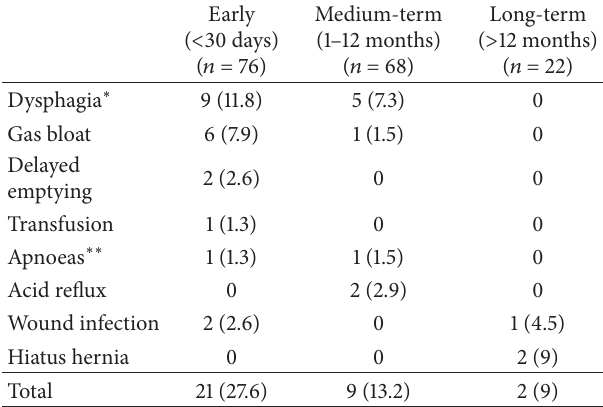
Table 2: All postoperative complications following laparoscopic Watson fundoplication ( 𝑛 = 76; percentages in